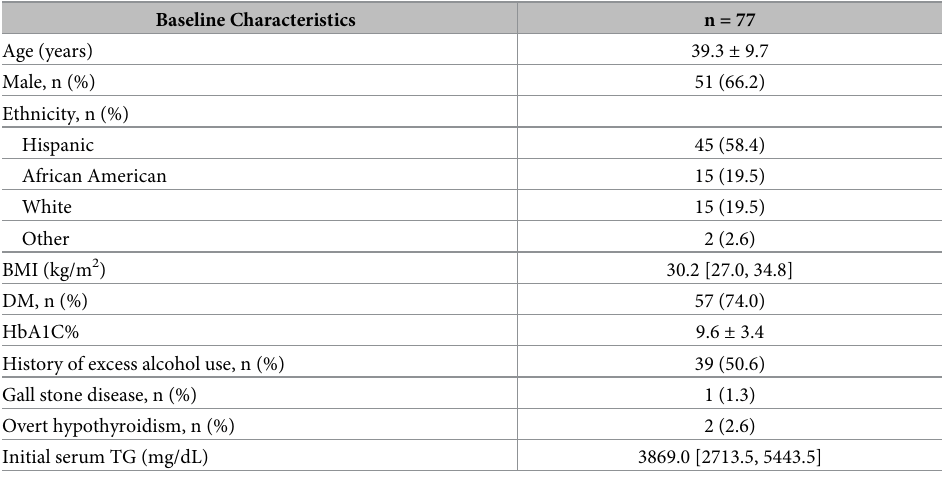
Table 1. Baseline characteristics of the study population.